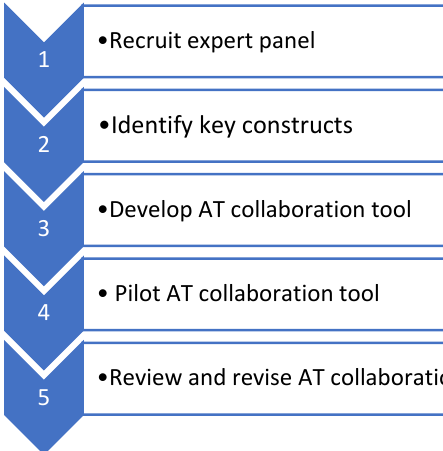
Figure 1. Method of iterative development and testing.